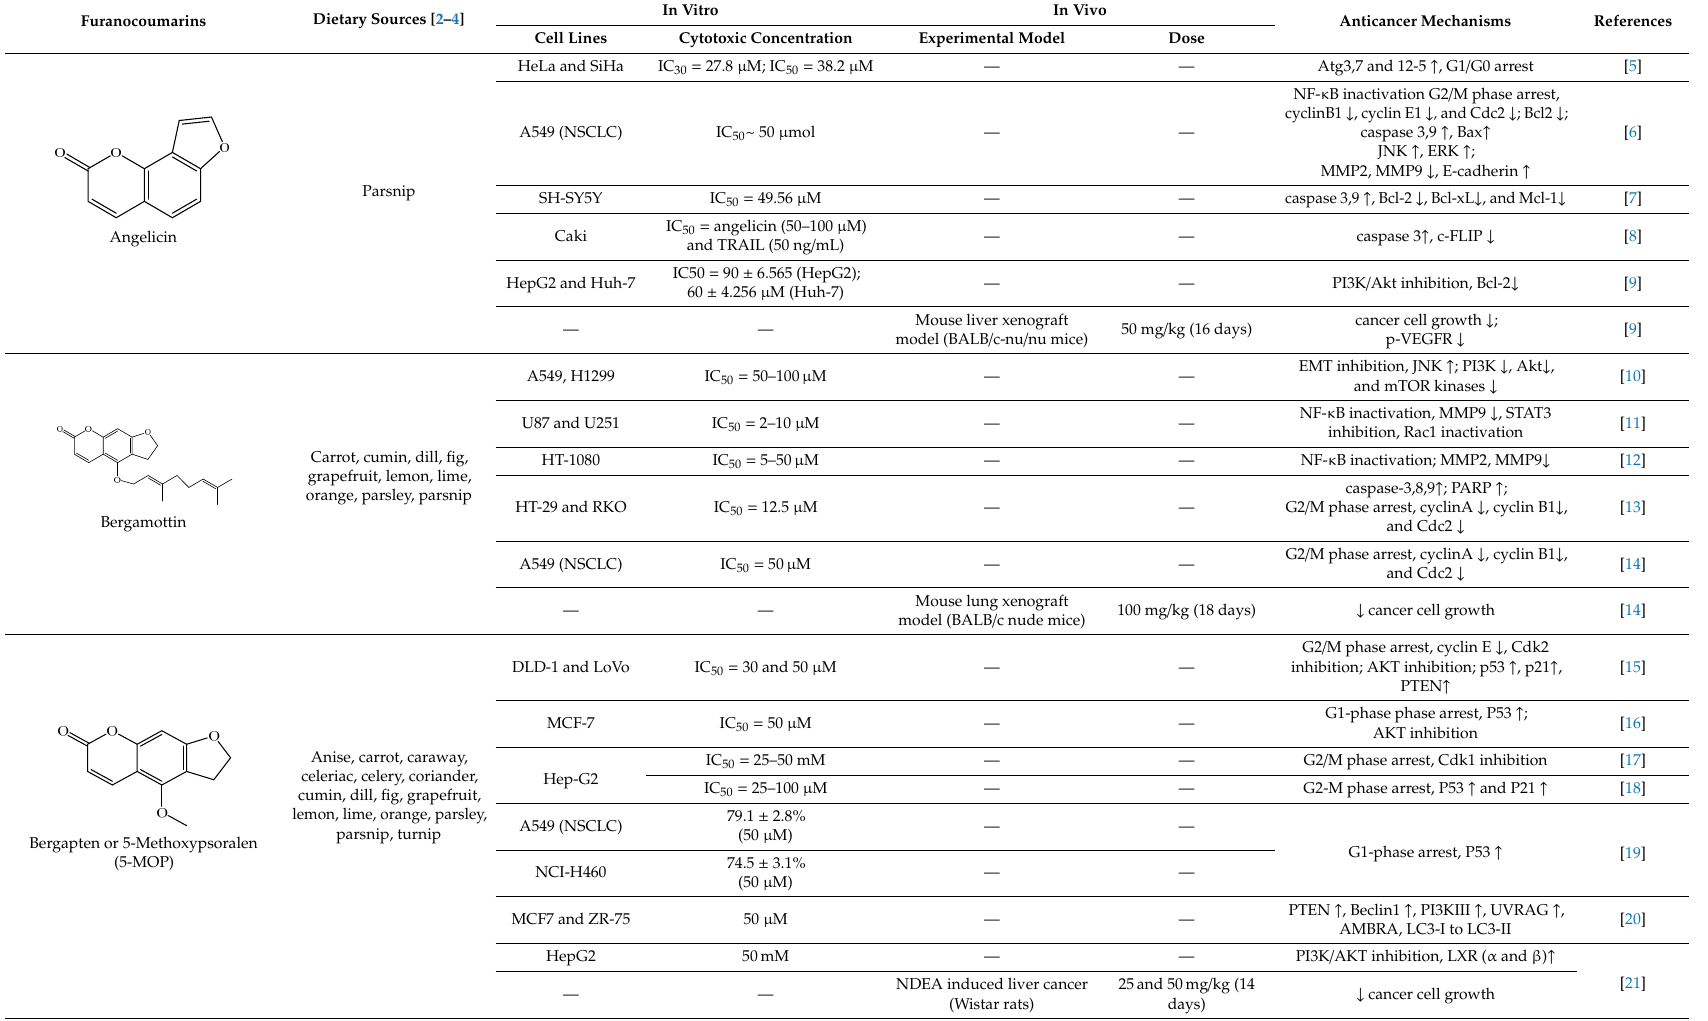
Table 1. Anticancer effects of furanocoumarins in the different reported studies.